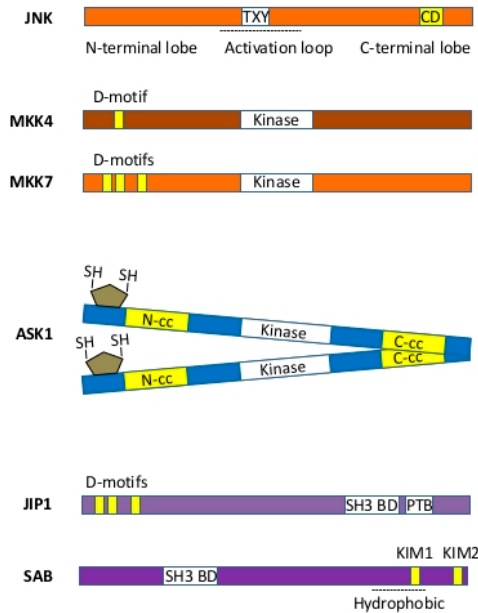
Figure 3. Schematic diagram of molecules involved in JNK activation loop. JNK is activated by dual threonine–tyrosine phosphorylation at (TXY) located within activation loop (indicated as black dotted line) by MKK4/7 through interaction with common docking site (CD) of JNK and docking motif (D-motif; JNK binding site indicated by yellow bars) of MKK4/7. CD of JNK is also shared with JIP and SAB which has one hydrophobic transmembrane spanning domain (indicated as dotted line). Two JNK binding sites on SAB are noted as KIM1 and KIM2 (indicated by yellow bars). Dimerization of ASK1 through interaction of N-terminal coil-coil domains (N-cc) and of C-terminal coil-coil (C-cc) doamins autoactivates ASK1. Removal of thioredoxin (indicated by gray polygon) by oxidation facilitates dimerization of